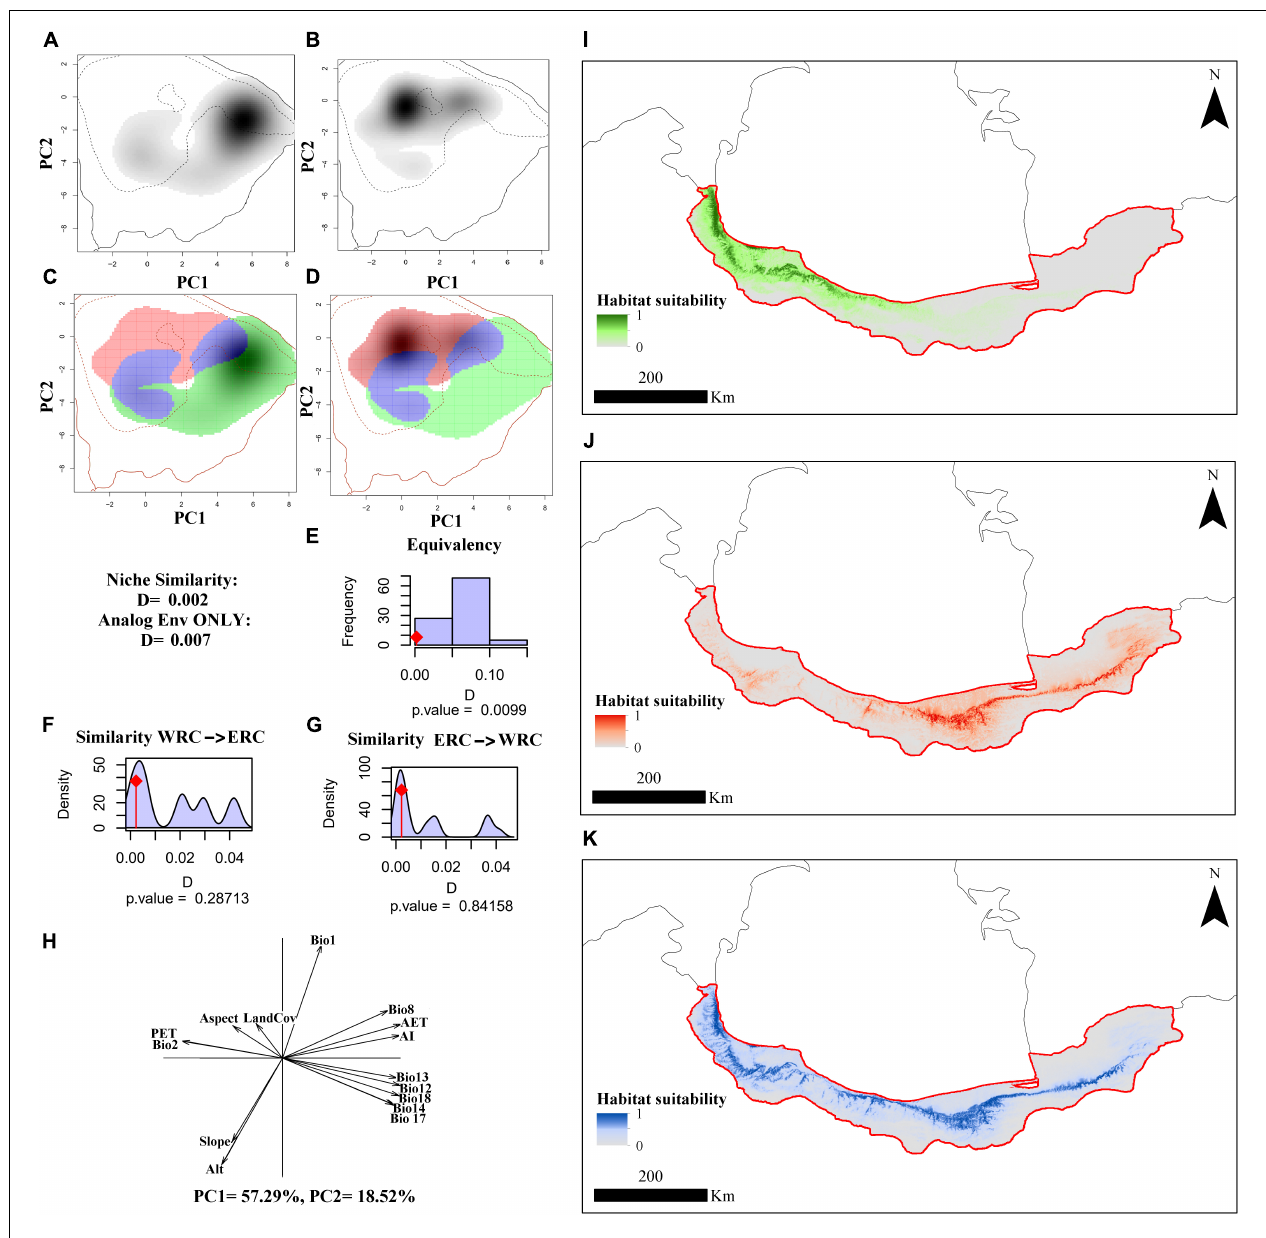
FIGURE 4 | The integrated climatic and macro-environmental niche of the Hyrcanian wood frog, Rana pseudodalmatina across Hyrcanian forests, Iran. Panels (A,B) illustrate the species’ niche in the western and eastern distribution ranges, respectively, along the two first axes of the PCA. The density of the species’ occurrences in the cell is shown in the gray shade. The solid and dashed contour lines represent 100 and 50% of the available (background) environment, respectively. Panels (C,D) represent the niche overlap values for western (WRC) and eastern regional clades (ERC), respectively. Histograms (E–G) show the observed niche overlap D between the two ranges (bars with a diamond) and simulated niche overlaps (gray bars) on which tests of niche equivalency (E) , niche similarity of WRC to ERC (F) , and niche similarity of ERC to WRC (A) . (H) The contribution of the bio-climatic and macro-environmental variables on the two axes of the PCA env and the percentage of inertia explained by the two axes. Potentially suitable areas are based on integrated bio-climatic and macro-environmental variables according to WRC (I) , ERC (J) , and species-level (K)